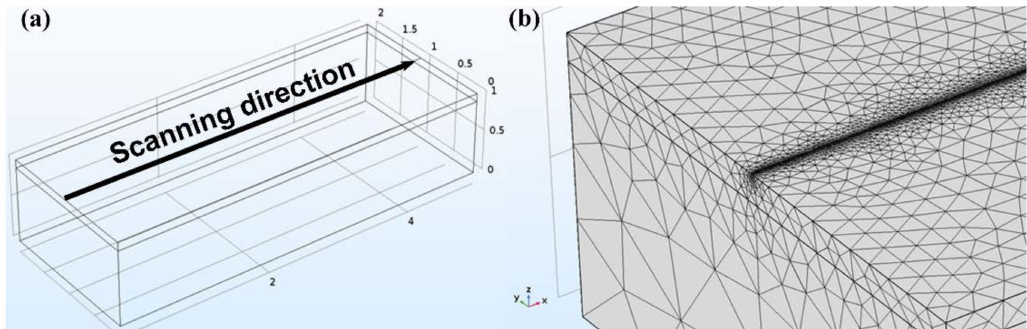
Figure 2. Schematic of the geometry ( a ) and the mesh model ( b ) used for the numerical